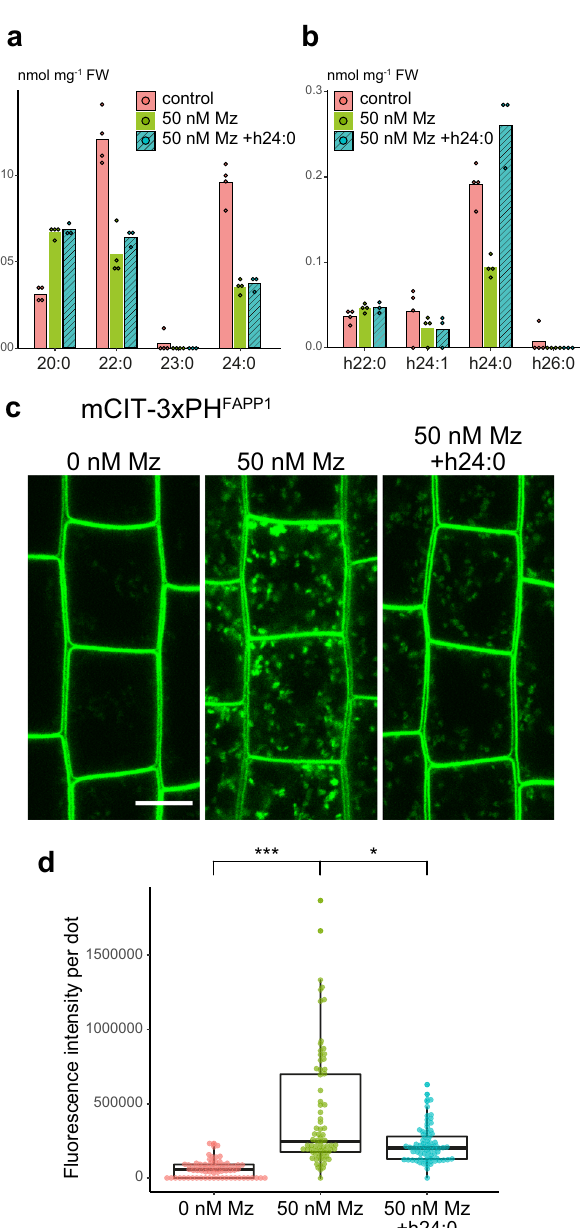
Fig. 4 α -hydroxylated h24:0 rescues the metazachlor-induced PI4P distribution defect at TGN. a, b GC-MS analysis of Arabidopsis roots in control condition (pink), metazaclor (Mz)-treated roots (green), and metazachlor-treated roots implemented with h24:0 (blue) ( n = 4 biological replicates, the dots show the dispersion of data). a Quanti fi cation of non- α - hydroxylated fatty acids and b α -hydroxylated fatty acids. External application of h24:0 in Mz-treated seedlings restores the level of h24:0 of control seedlings. c Confocal micrographs of Arabidopsis root epidermal cells expressing the PI4P biosensor mCIT-3xPH FAPP1 upon 0, 50 nM Mz treatment or 50 nM Mz treatment + h24:0 add-back. Scale bar, 10 µ m. d Quanti fi cation of the fl uorescence intensity at intracellular dots. While Mz treatment induces PI4P accumulation in intracellular dots, external application of h24:0 rescues this defect. n = 75 cells from 25 roots for each condition. Statistics were done by two-sided Dwass-Steel-Critchlow-Flinger multiple comparison test with Monte Carlo method (10000 iterations). * P < 0.01, *** P < 0.0001. Each element of the boxplot indicates the following value: center line, median; box limits, the fi rst and third quartiles; whiskers, 1.5× interquartile range; points above or below the whiskers,